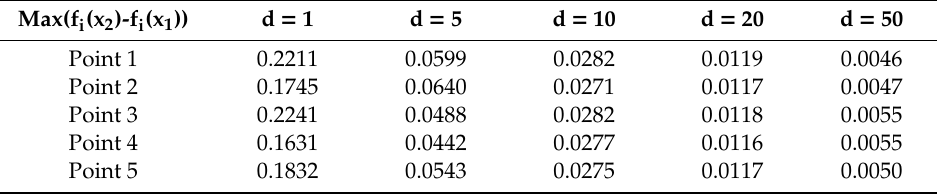
Table 1. Observation data at the distance ( = 0.5) per correlation distance.